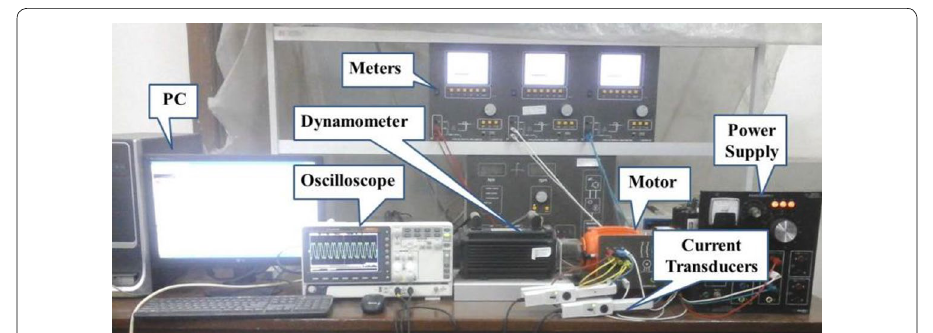
Fig. 6 The experimental setup at the laboratory